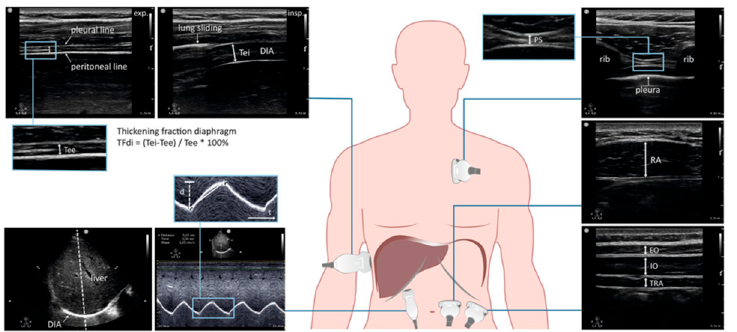
Figure 2. Clinical applications of respiratory muscle ultrasound (courtesy of Prof. Huiks